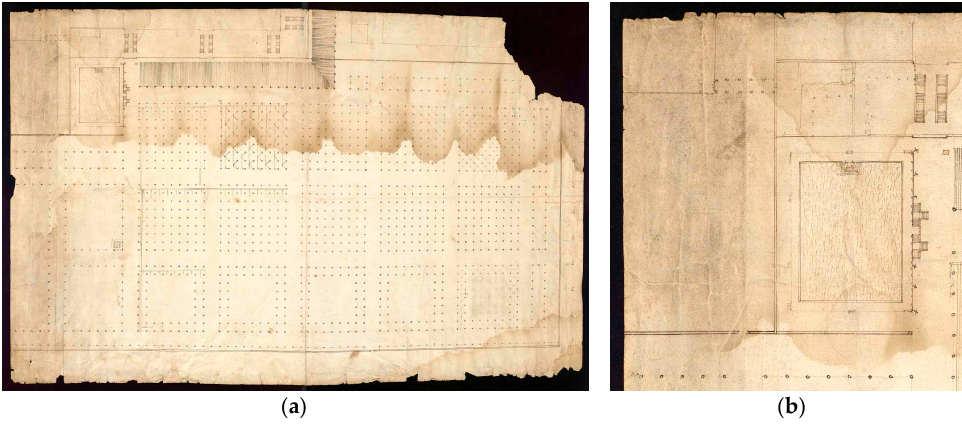
Figure 11. Francisco de Mora, ca. 1585: Plano de la huerta del Monasterio de San Lorenzo de El Escorial . ( a